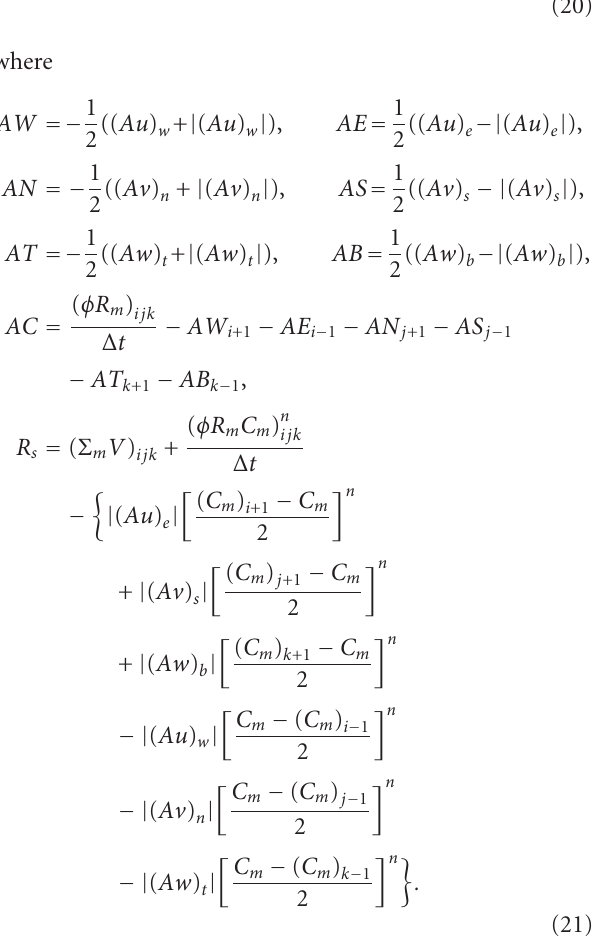
Figure 3: Determination of the boundary states.